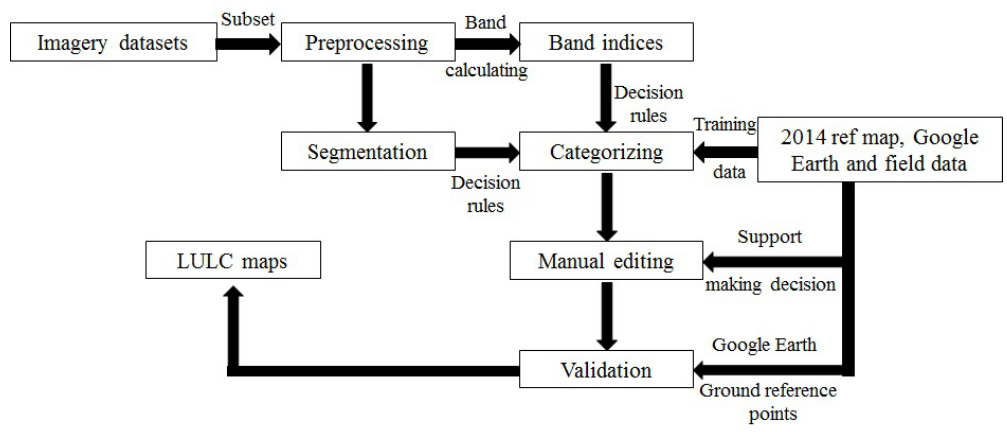
Figure 6. Flowchart of image analysis and maps generalization